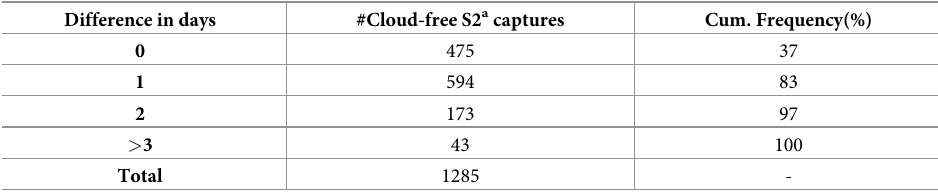
Table 1. Difference in days between ground and satellite observation pairs.